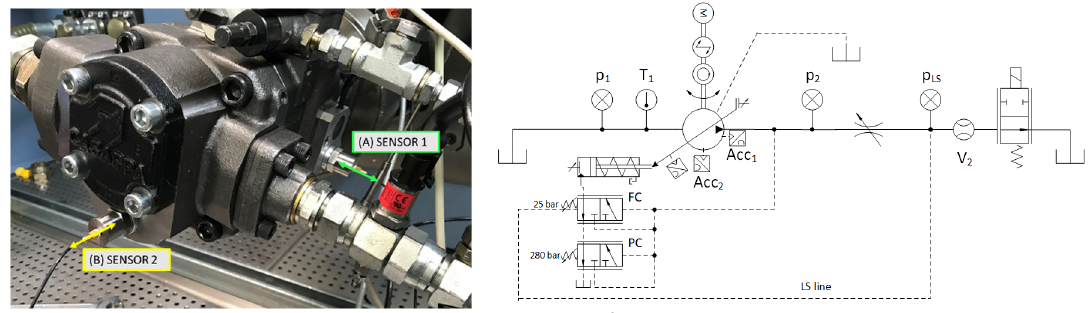
Figure 2. ( a ) Position on the pump of the two accelerometers. ( b ) Hydraulic scheme of the experimental layout.